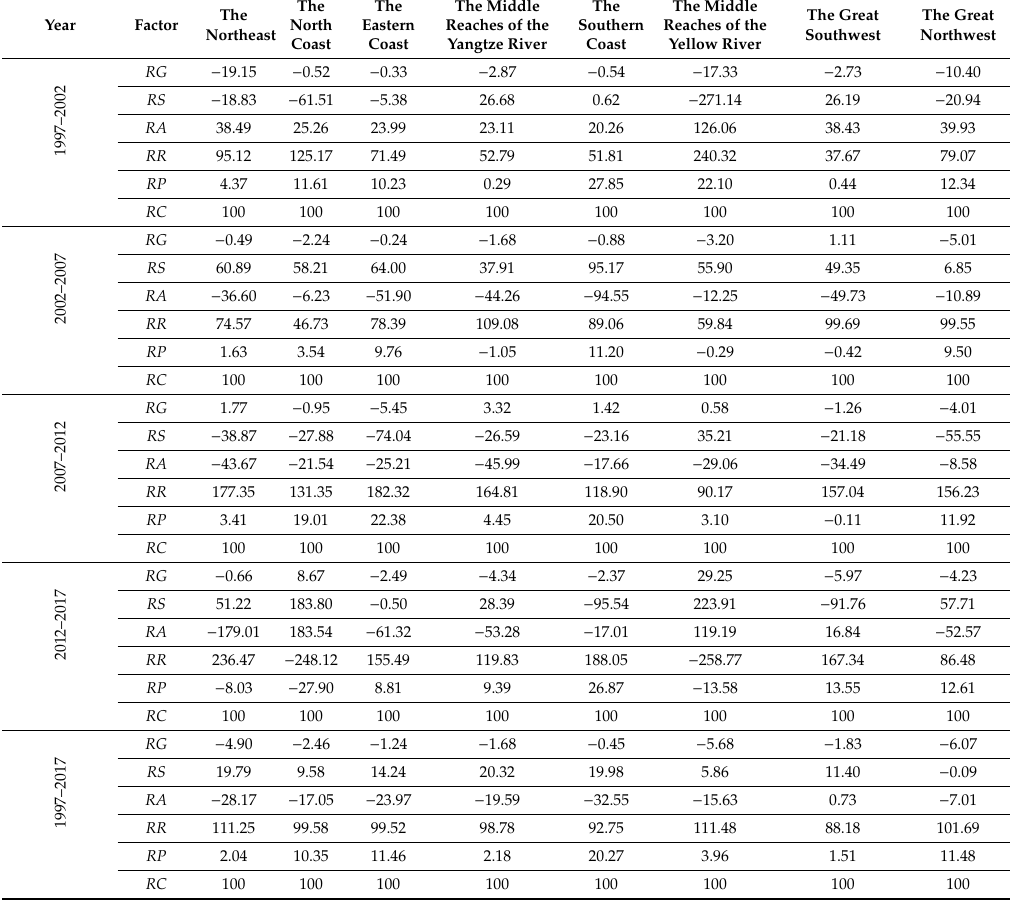
Table 5. Contribution rate of LMDI decomposition of carbon emissions in transportation industry in the 8 regions (unit: